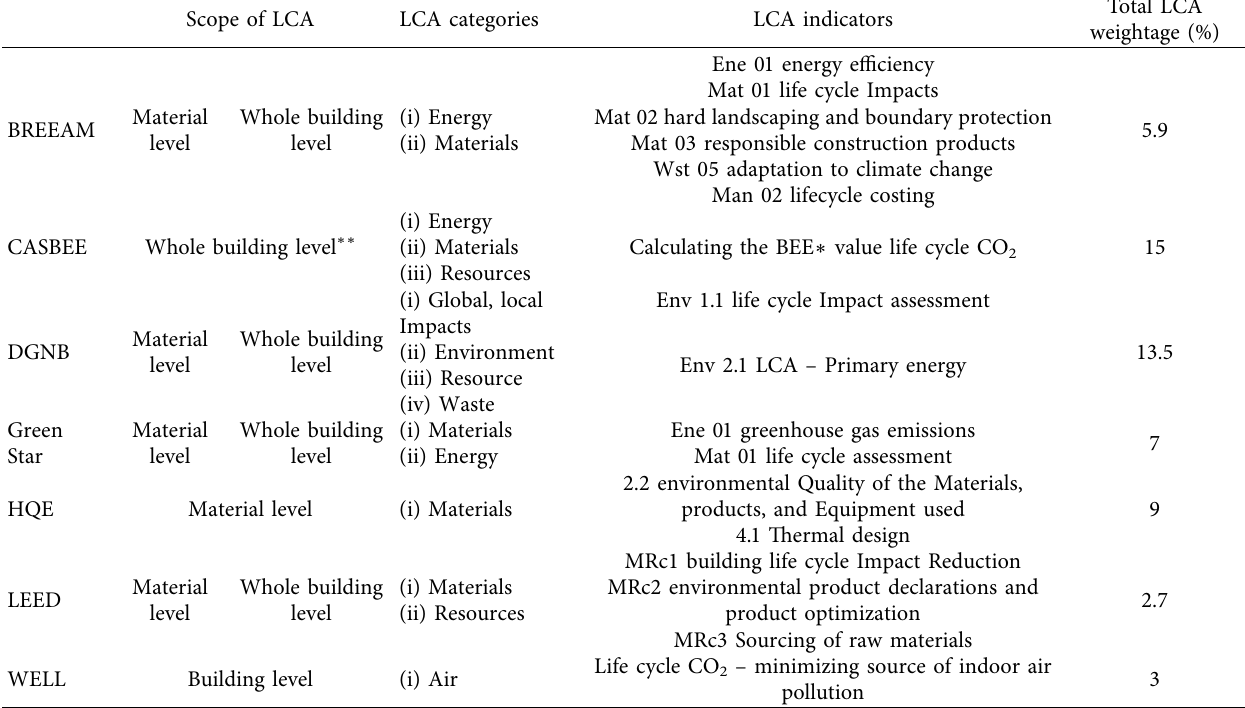
Table 8: A comparison table to investigate the integration of LCA in BEA methods